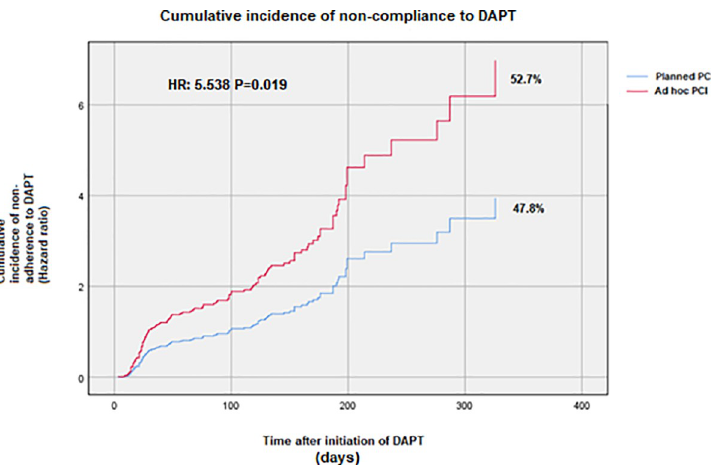
Fig 2. Cumulative incidence of non-compliance to DAPT at 12 months’ follow-up. Dual antiplatelet therapy (DAPT), percutaneous coronary intervention (PCI).